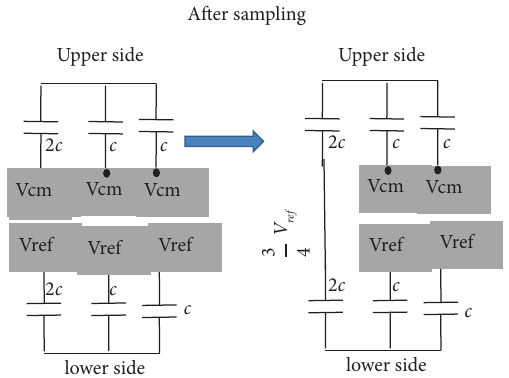
Figure 31: Te charge-sharing voltage switching scheme.